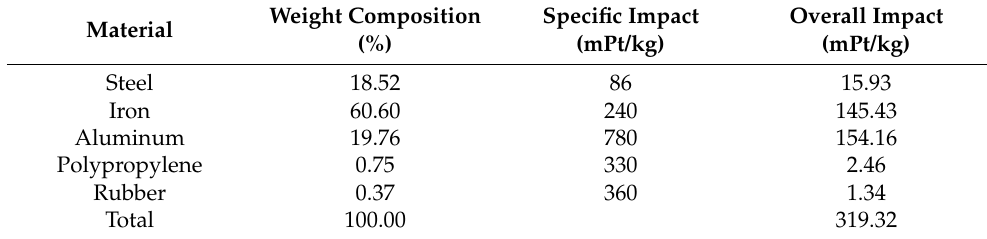
Table 3. Environmental impacts of the engine (construction